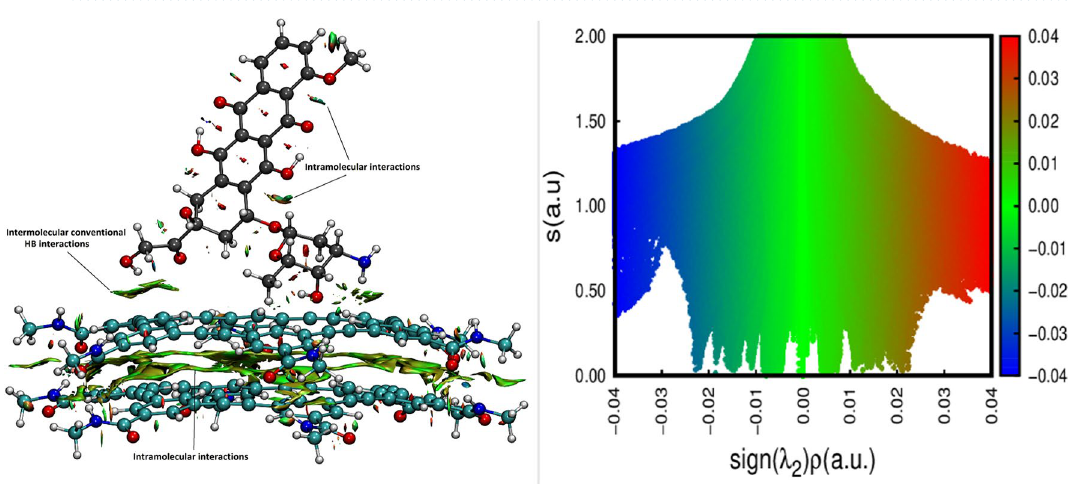
Figure 3. Reduced density gradient isosurface map of DOX/hexakis dimer. The isovalue is set to 0.04 a.u. The value of Sign(λ)ρ in the surfaces is represented by filling color according to the color NCI plot analysis. The use of NCI index enable the understanding of the interactions in a complex since each method can recognize regions of the weak and strong electron pairing respectively. The NCI index of Yang and co-workers is based on the reduced density gradient (RDG =| ∇ ρ|/2(3π 2 ) 1/3 ρ 4/3 ), and also is suitable to define the nature of the weak bonds involved in the structures. The NCI isosurfaces of the reduced electron density gradient between the DOX molecule and hexakis dimer for the most stable complex is depicted in Fig. 3. The symbol-coding scheme used for isosurfaces extraction are defined as follows: blue indicates the strong attractive interaction, green indicates the intermediate interactions, such as π-π stacking and H-π interactions, while red suggests repulsive interactions. According to the NCI plot (see Fig. 3), the green color that appears around the aromatic rings of the hexakis dimer demonstrates their attractive van der Waals (vdW) interactions. A closer look into the colors in these regions showed that the colors could be mixed and present half red and the other half-blue color. These areas are related to the electrostatic and intramolecular hydrogen bonding interac- tions between the hydrogen atoms in N–H groups and the oxygen atoms in C=O groups of the two plates of hexakis. It can also be seen from Fig. 3 that the hydrogen bonds appear, blue NCI domains, in the region where the O and N atoms of DOX interact with the hydrogen atoms of the carrier. The attractive vdW interactions are also observed between O atoms of drug and the C atoms of the carrier surface. The result of NCI indicate the hydrogen bonding being responsible for the enhanced binding with the DOX molecule in the DOX-hexakis dimer complexes.